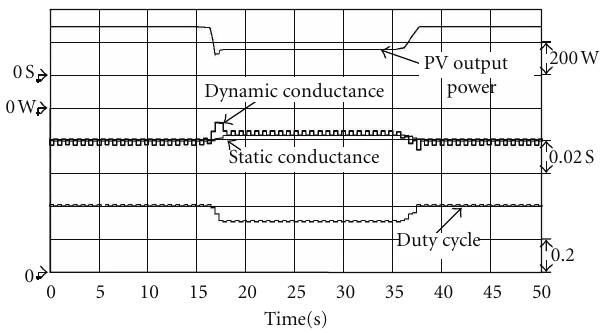
Figure 11: Simulated output power, dynamic conductance, static conductance, and duty cycle waveforms of a PV module array using the proposed extension method under irradiation that dropped from 1,000 W/m 2 to 700W/m 2 and then increased back up to 1,000 W/m 2 . Table 3: Component parameters of the implemented MPPT circuit.